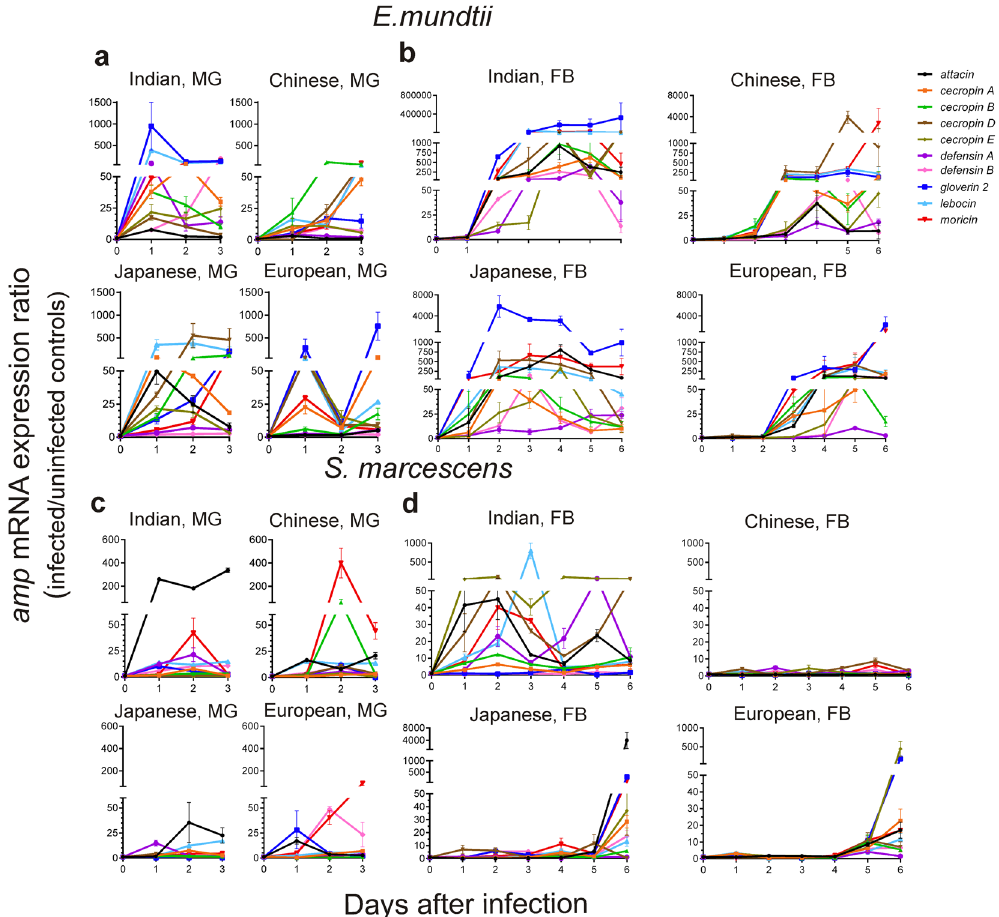
Figure 2. Local and systemic AMP expression induction in the four B . mori strains during E . mundtii or S . marcescens infections. AMP mRNA expression (mean ± SEM, nine samples pooled in three replicates per time per condition) was monitored for three (Midgut, MG) and six days (Fat bodies, FB) after a 24 h oral infection with E . mundtii ( a , b ) or S . marcescens ( c , d ). AMP expression ratio represents the AMP/ actin3 mRNA levels of infected samples over those of their relative uninfected controls. All AMP genes showed significant variations in expression ratio during time (p < 0.05 in Kruskal-Wallis test), except for def B in the European strain in ( a ), cec B in the Chinese strain in ( b ), att , leb and mor in the Chinese strain in ( d ) (statistical details in Supplementary Table